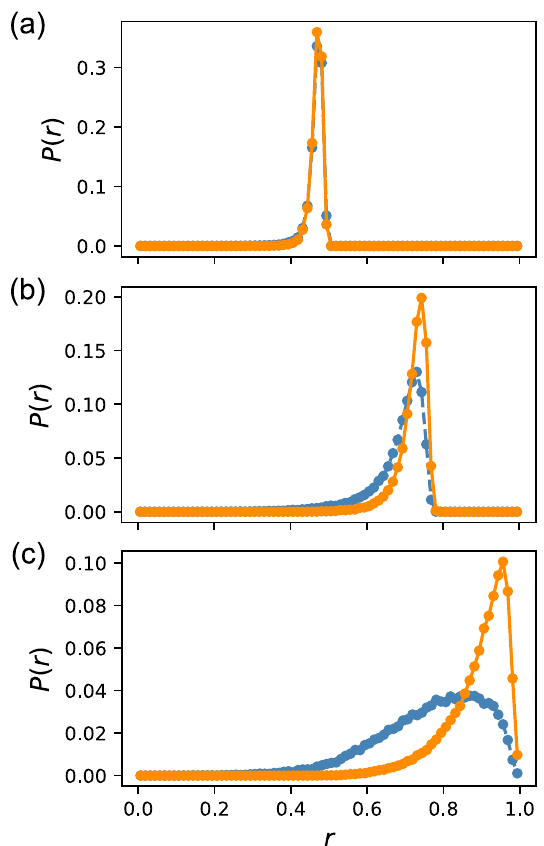
Fig 3. Probability distributions of the robustness measure r . (a) f 2 [0.5, 0.51) (b) f 2 [0.8, 0.81) (c) f 2 [0.99, 1.0]. The orange solid lines represent Evo50 and the blue dashed lines represent random sampling. r was divided into 80 bins because otherwise, unnecessary oscillation appeared in the distribution, owing to the discreteness of the number of essential edges. The distributions for the ES were corrected using the reweighting method described in the text.